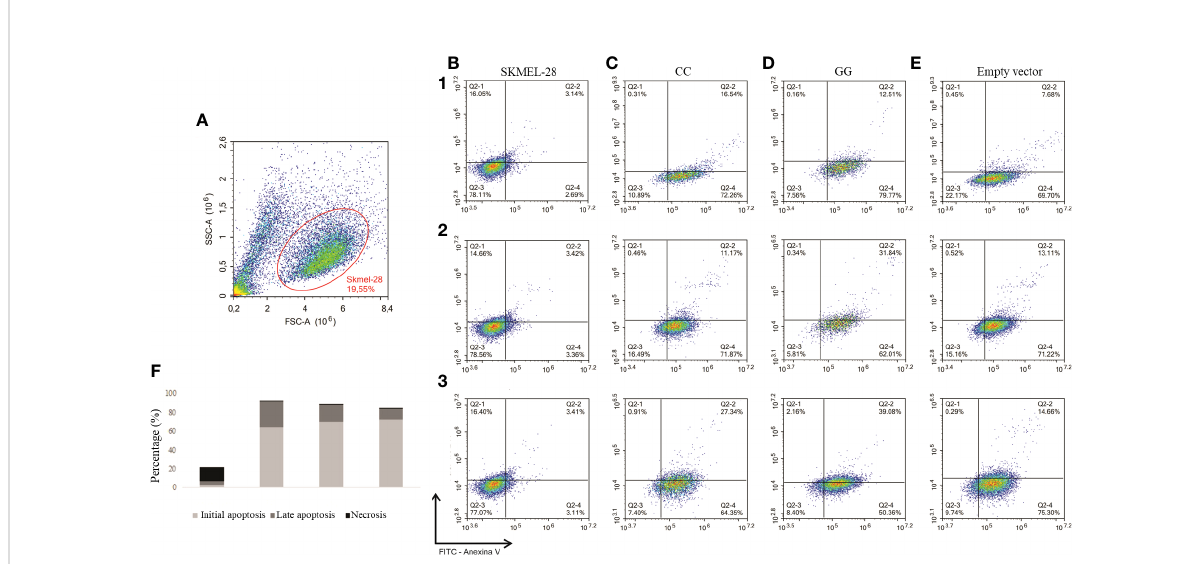
FIGURE 3 Detection of early and late apoptosis by fl ow cytometry in SKMEL-28 cutaneous melanoma cell line genetically modi fi ed to present the different genotypes of STAT3 c.-1937C> G. The cells were subjected to nutrient deprivation, treated with 200 µM of hydrogen peroxide for 24 h, and marked with the antibodies Annexin V and 7-AAD. Three independent experiments were performed (1, 2, and 3). The identi fi cation of cells was performed by separation by size (FSC) and granularity (SSC) (A) . Dot plots referring to experiments one to three for the analysis of cell apoptosis, in which viable cells (Q2-3), cells in initial apoptosis (Q2-4), cells in late apoptosis (Q2-2), and necrosis (Q2) were identi fi ed in SKMEL-28 (B) , cell with CC genotype (C) , cell with GG genotype (D) , and cell transfection with empty vector (E) . For the statistical tests, values with p < 0.05 were considered signi fi cant. The results are shown as means between groups: CC vs. GG (initial apoptosis: 69.49 vs. 64.05%, p = 0.57; late apoptosis: 18.35 vs. 27.81%, p = 0.36; necrosis: 0.56 vs. 0.89%, p = 0.64), CC vs. empty vector (initial apoptosis: 69.49 vs. 72.07%, p = 0.44; late apoptosis: 18.35 vs. 11.82%, p = 0.27; necrosis 0.56 vs. 0.42%, p = 0.50), and GG vs. empty vector (initial apoptosis: 64.05 vs. 72.07%, p = 0.40; late apoptosis: 27.81 vs. 11.82%, p = 0.12; necrosis 0.89 vs. 0.42%, p = 0.54) (F)